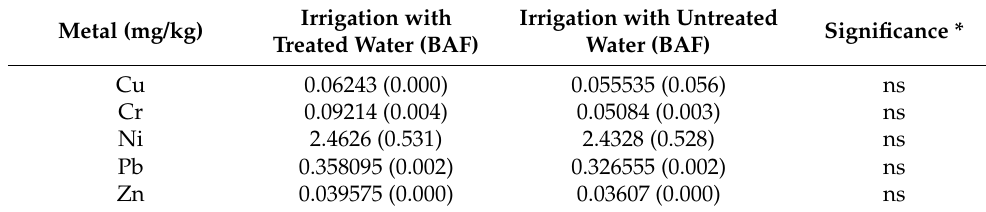
Table 2. Heavy metal content in lettuce ( Lactuca sativa ).